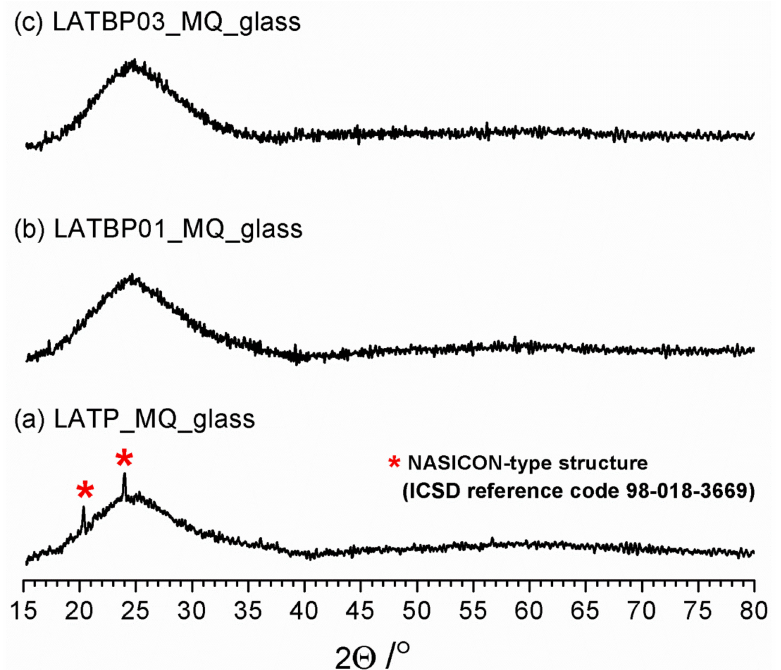
Figure 1. Diffractograms for LAT(B)P_MQ_glass series. Traces of Li 1.3 A l0 . 3 Ti 1.7 (PO 4 ) 3 (LATP) precip- itations are marked by asterisks. ( a )LATP_MQ_glass ( b ) LATBP01_MQ_glass ( c ) LATBP03_MQ_glass.